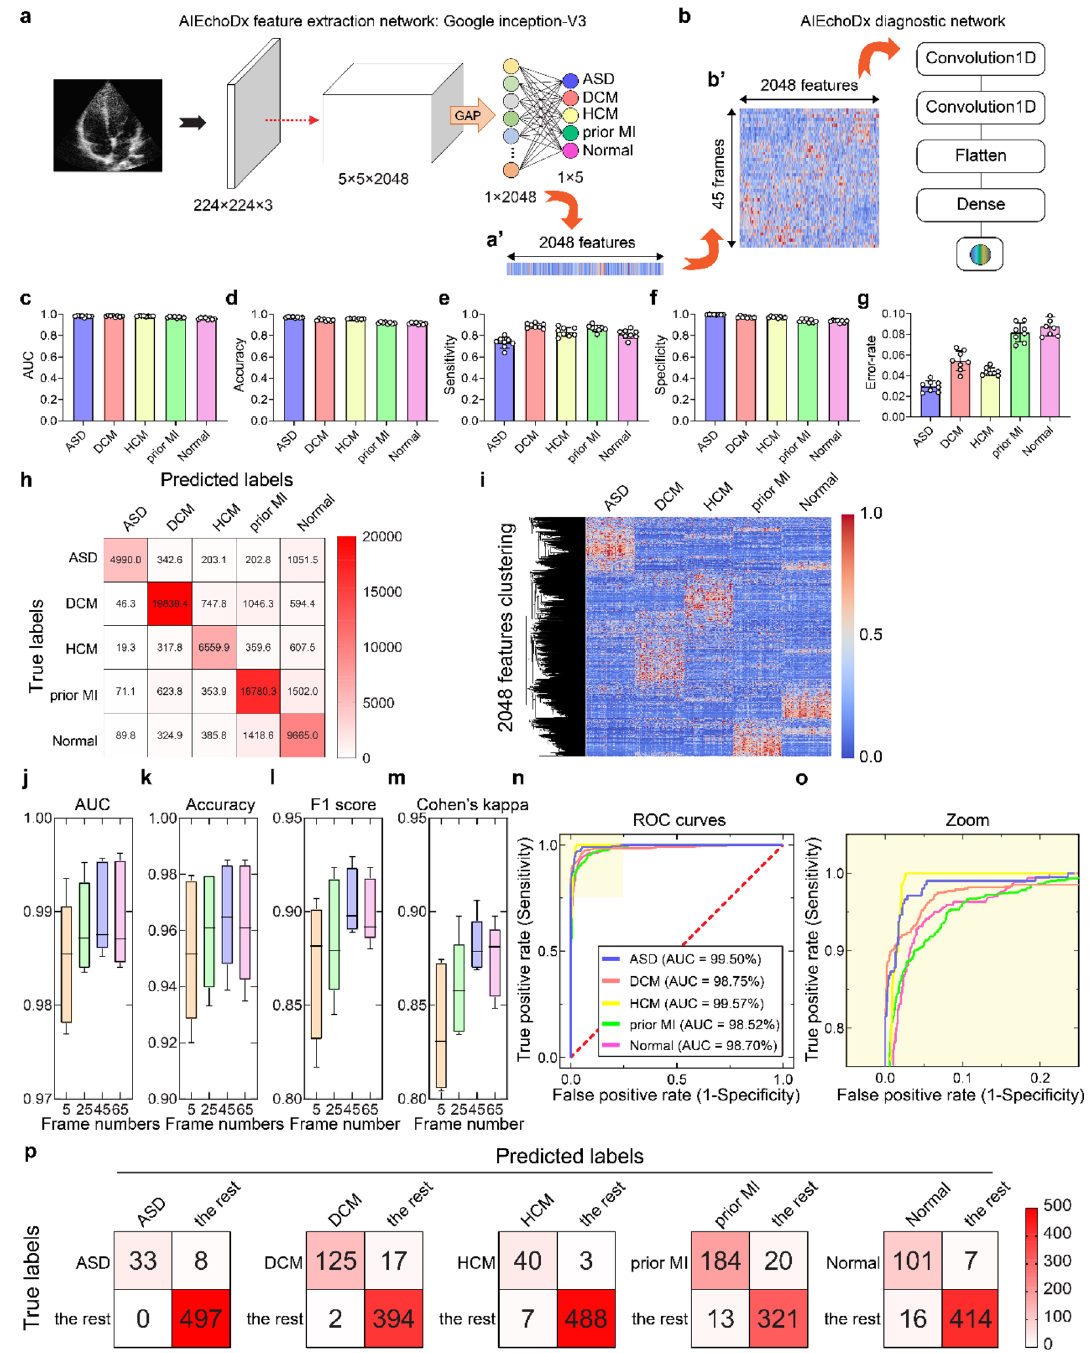
Figure 2. Performance of AIEchoDx. ( a ) Structure of feature extraction network; ( a’ ) represents a heatmap of the features of one image extracted from the last hidden layer. ( b ) Structure of the diagnostic network; ( b’ ) represents a heatmap of the feature matrix of a 45-frame echo video as an input of the diagnostic network. ( c – g ) The AUC ( c ), accuracy ( d ), sensitivity ( e ), specificity ( f ), and error-rate ( g ) values of the eightfold cross- validation results of the feature extraction network. ( h ) Confusion table displays the eightfold cross-validation results of the feature extraction network classified five categories from the test dataset 1. ( i ) The clustered heatmap illustrated 2048 features were extracted from the last hidden layer of the feature extraction network. 50 single frames from each category were selected from 50 patients for plotting the heatmap. ( j – m ) The frame number versus the values of matrix accuracy ( j ), F1 score ( k ), Cohen’s kappa ( l ), and AUC ( m ) of cardiac diseases and normal subjects from the diagnostic network. The diagnostic network reading a 45-frame video could achieve the best performance of the prediction in test dataset 1. ( n , o ) Receiver operating characteristic (ROC) curves of the 45-frame diagnostic model from test dataset 1 (The AUC values of ASD, DCM, HCM, prior MI, and Normal were 99.50%, 98.75%, 99.57%, 98.52%, and 98.70%, respectively). ( p ) The confusion matrices represent the prediction results of the five classifiers for test dataset